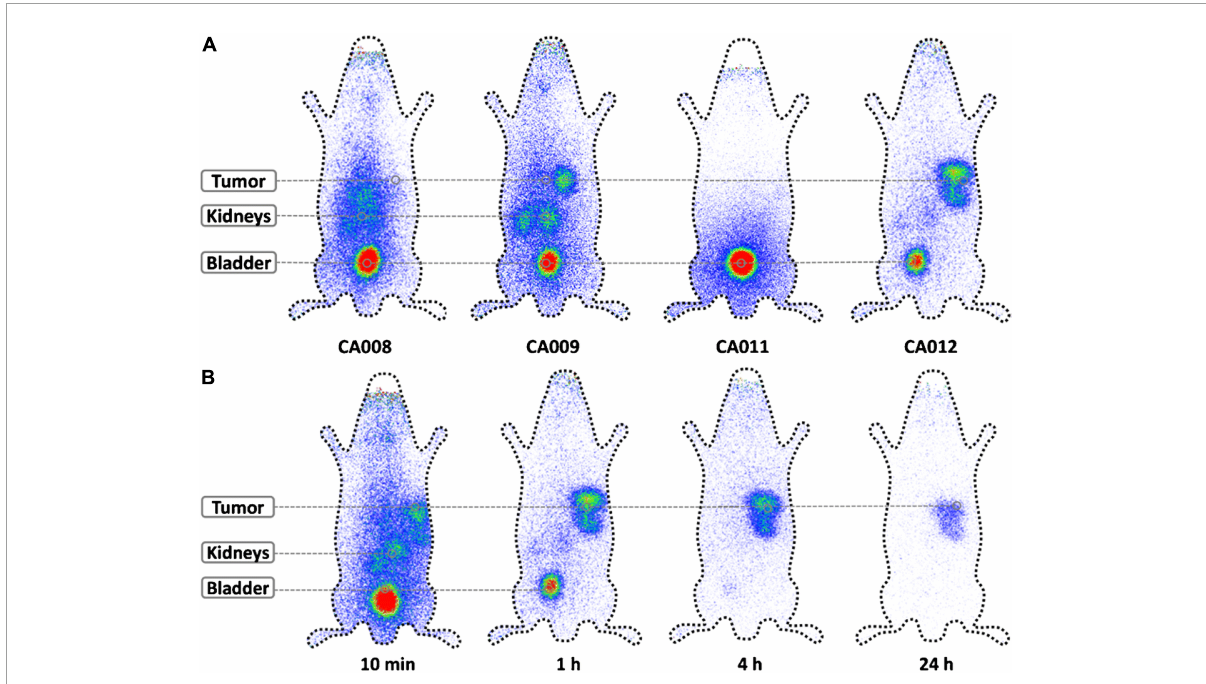
FIGURE4 Theranostic pairs used for pharmacokinetics and dosimetry estimations. The G -emitting 203 Pb was used as imaging surrogate of therapeutic 213 Pb to estimate the pharmacokinetics and dosimetry of different PSMA-targeting radiopharmaceuticals. Planar scintigraphy scans of (A) different radioconjugates 1 h after injection, and (B) 203 Pb-CA01 at different time points. Adapted with permission from ref 66. Copyright 2018 Springer